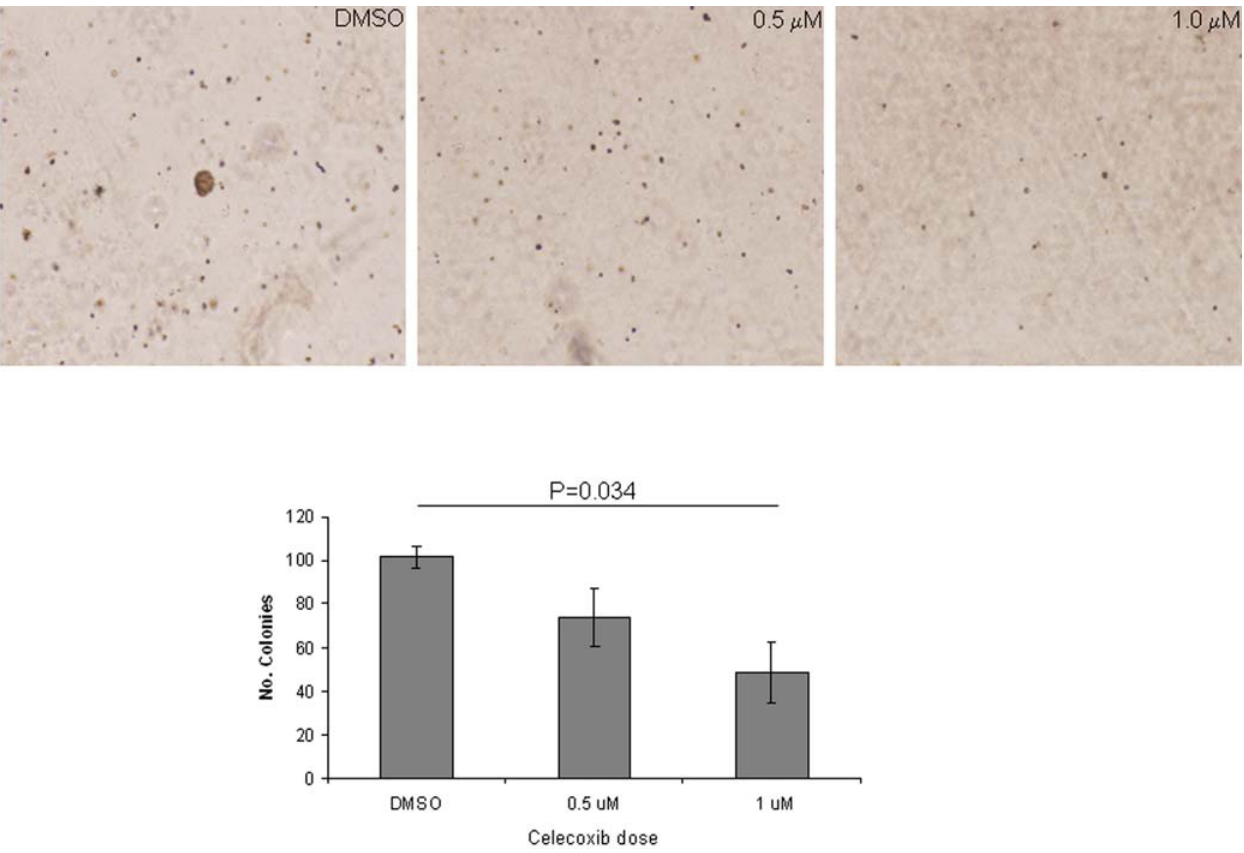
Figure 4. Cyclooxygenase-2 inhibition decreases NSCLC anchorage-independent growth. Representative images of colonies of NSCLC cell lines (upper panels) were quantified (lower panels) after growing them in soft agar in the presence or absence of celecoxib. Results are the means of at least three independent experiments.